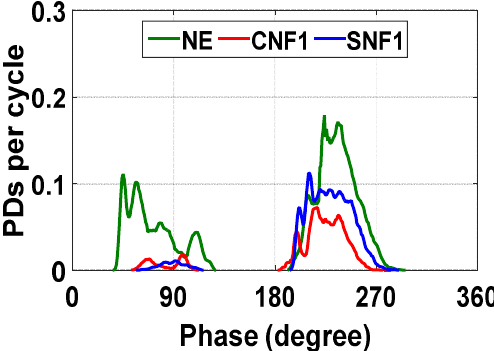
Figure 6. PD phase distribution as a function of nanoparticle type.